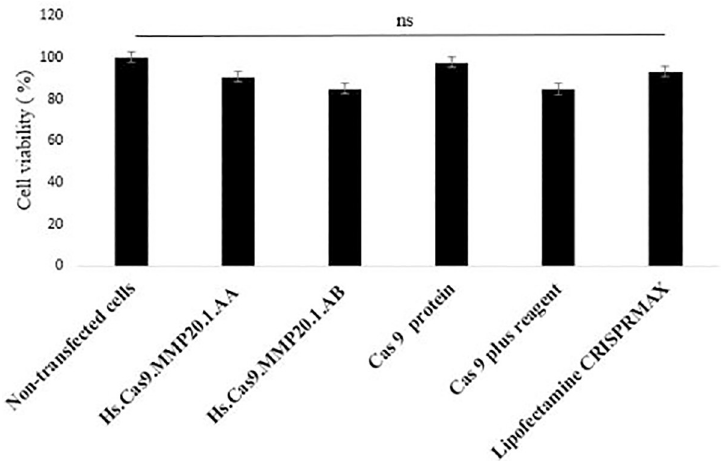
Fig 3. Cytotoxic effect of CRISPR-Cas9 reaction components on A549 cells lines. Cells were treated with individual reaction components for 48 h and the cell viability was determined by MTT assay. The data were expressed as mean values ± Standard Error of the Mean (S.E.M) of viable cells (n = 3).